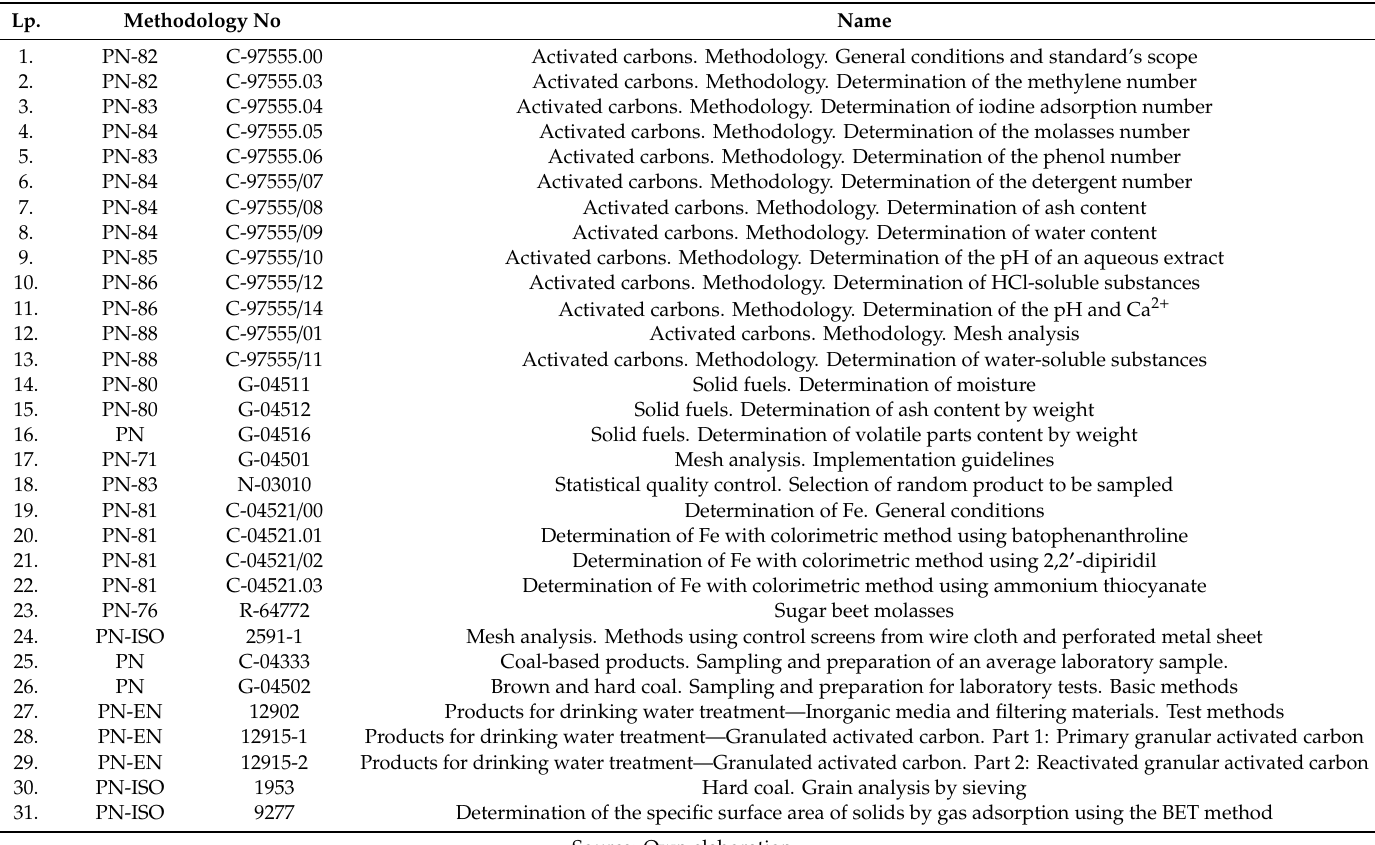
Table 4. Applied methodology for determination of binders and carbon